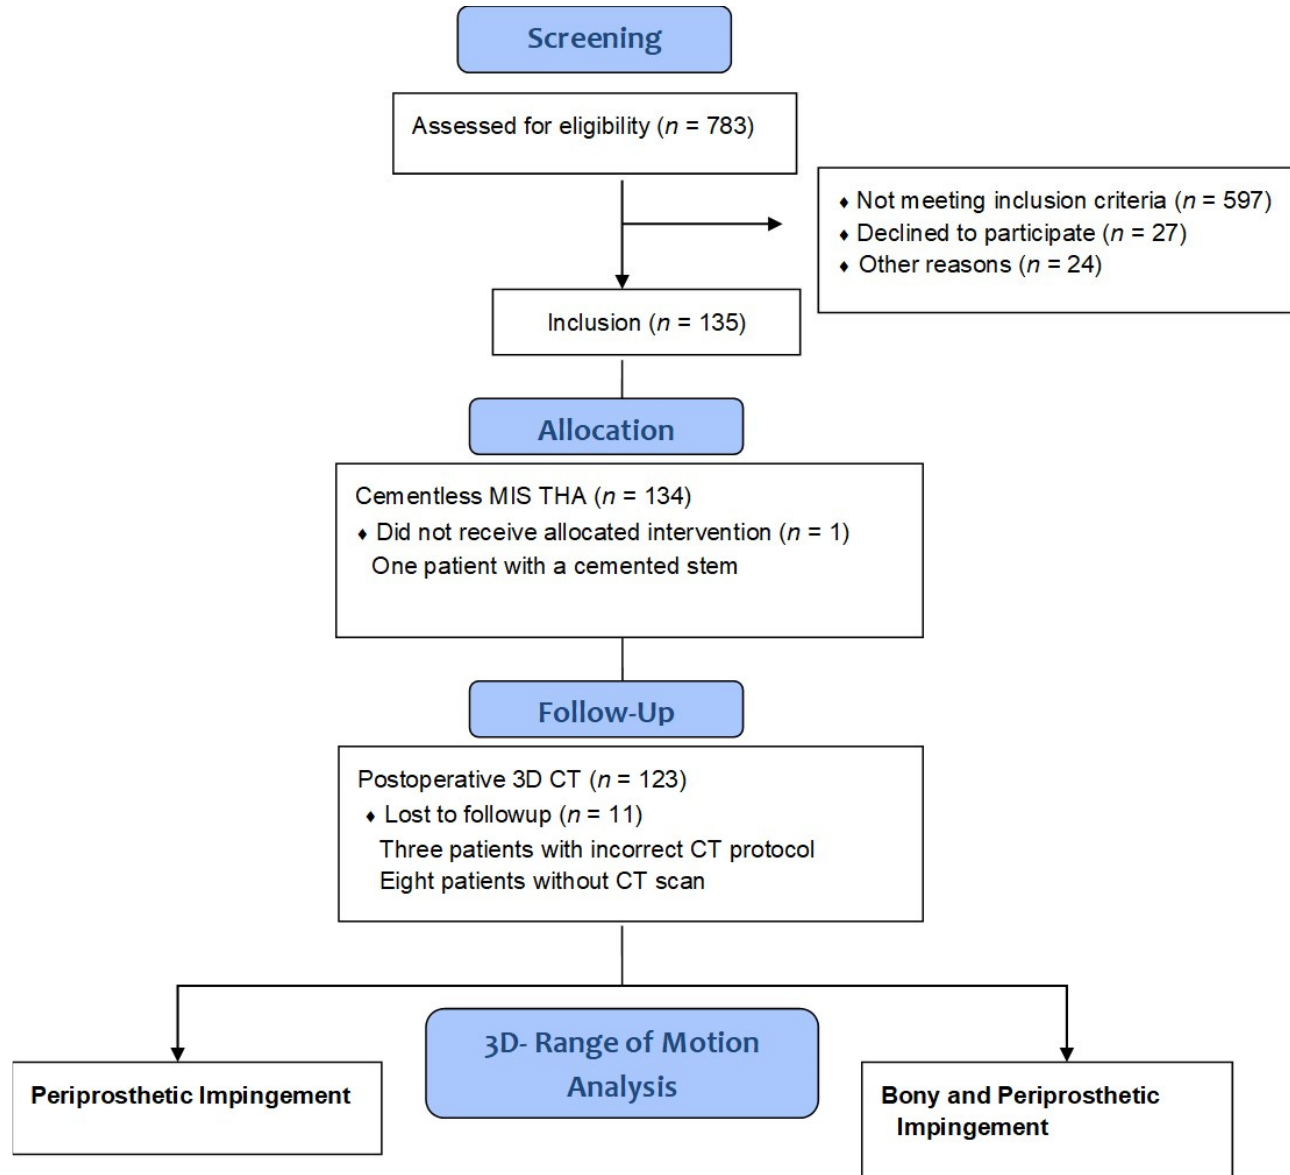
Figure 1. Flow diagram of the participants in this study. MIS THA, minimally-invasive total hip arthroplasty; 3D CT, three-dimensional computed tomography.